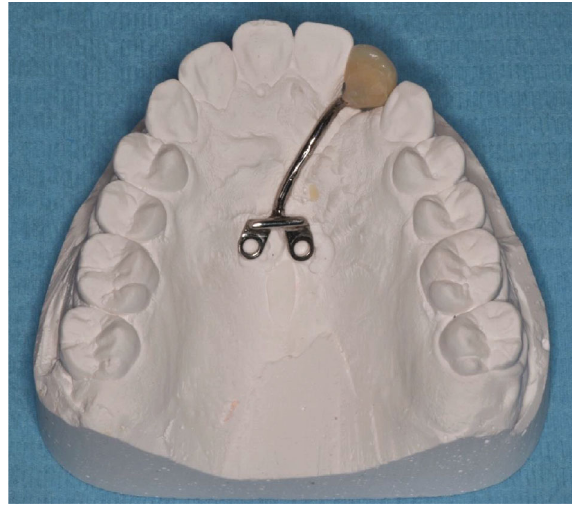
Figure 9: Temporary prosthetic tooth supported by orthodontic palatal